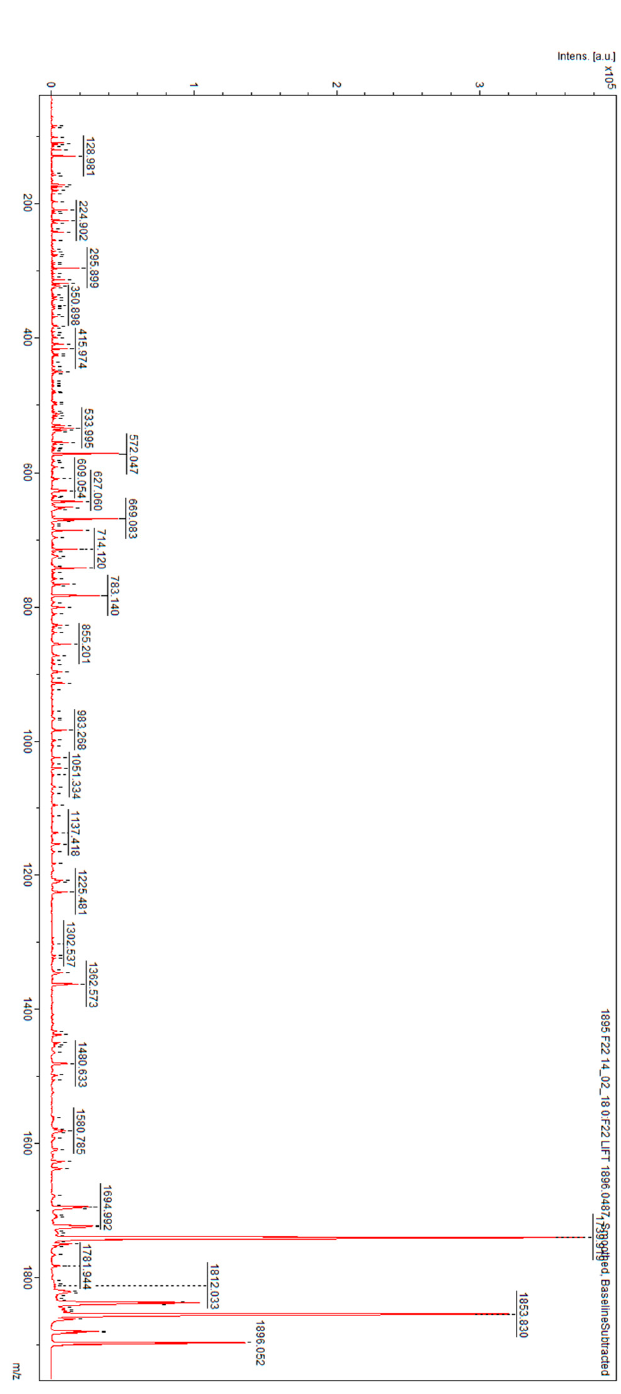
Figure 4. Fragmentation spectrum of precursor ion of m/z 1895.43 identified as complement C4A.